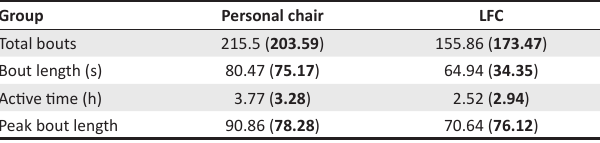
FIGURE 5: Changes in propulsion efficiency (metres per cycle) before and after LFC